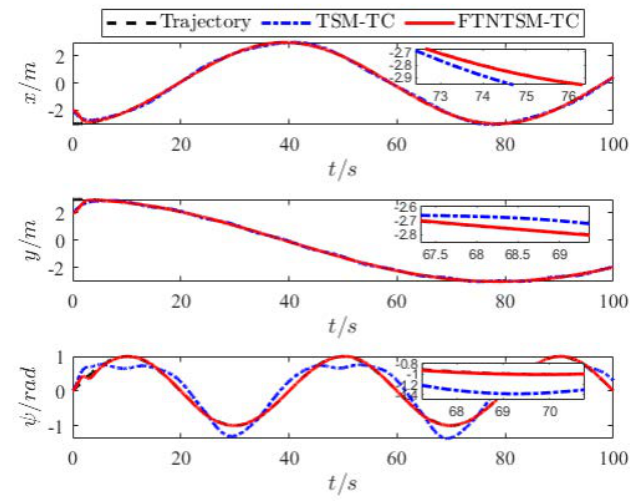
Figure 4. Position tracking of TSM-TC and FTNTSM-TC.